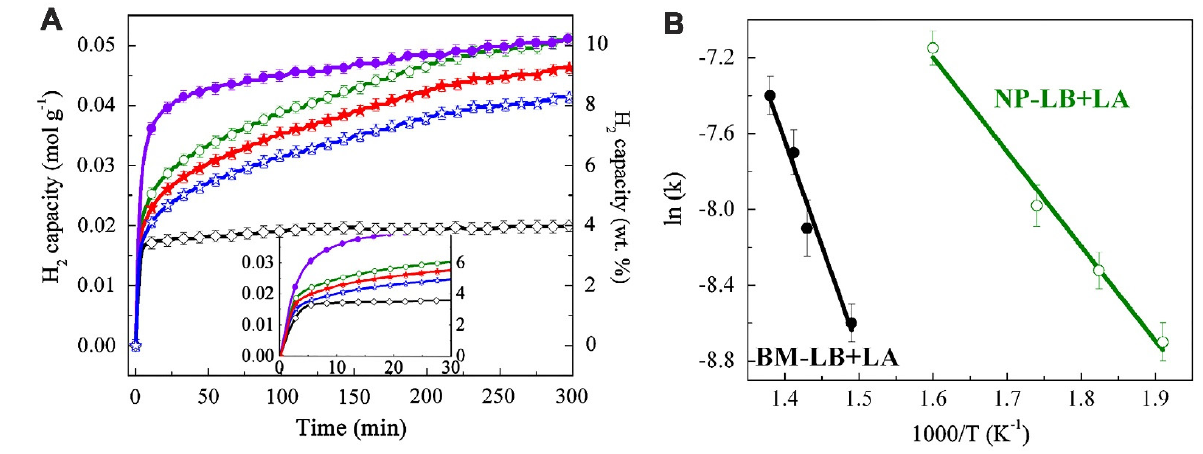
Figure 5. ( A ) Isothermal H 2 release of the nanoconfined 2LiBH 4 –LiAlH 4 composite at 250 C (blue), 275 C (red), 300 C (green) and 350 C (violet), including the post-milled 2LiBH 4 –LiAlH 4 composite at 350 C (}) for comparison. The inset is an enlargement of ( A ) for dehydrogenation time from 0 to 30 min. ( B ) Arrhenius plots of the temperature-dependent rate data for the post-milled and nanocon-